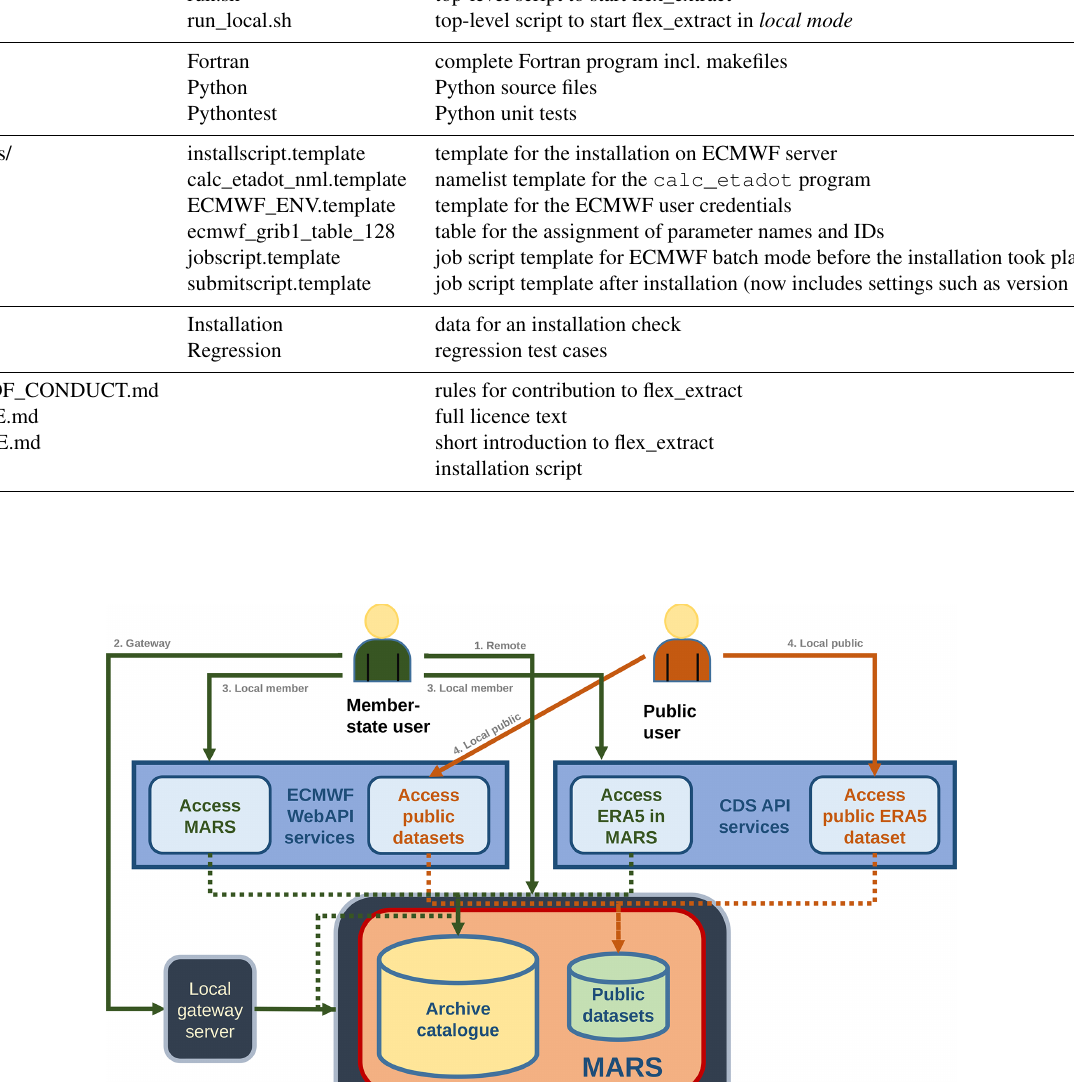
Geosci. Model Dev., 13, 5277–5310,